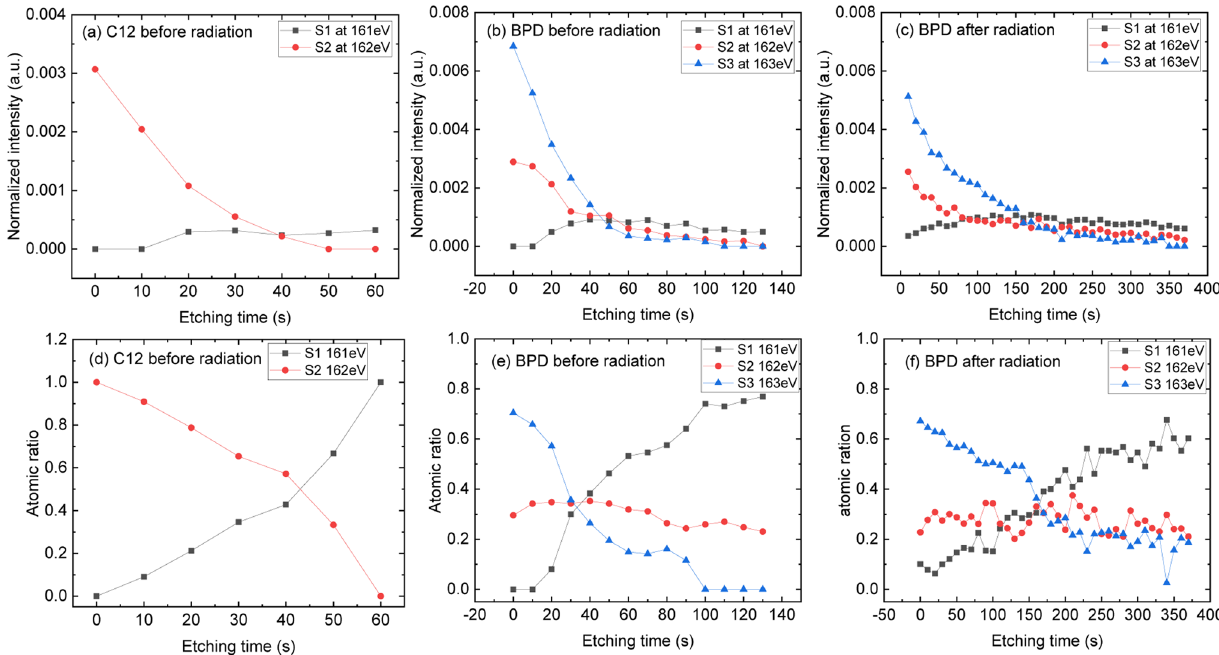
Figure 3. ( a – c ) Intensities (normalized to the Au4f signal) of the components of S2p spectra of pristine C12 SAM ( a ), pristine BPD SAM ( b ) and irradiated BPD SAM ( c ) as a function of etching time. The same results are presented in ( d – f ) normalizing the signal intensities to the total signal intensity to see the percentage contribution of different components. S1, S2 and S3 corresponds to the S2p3/2 at 161.1 eV (component S1), 162.0 eV (component S2) and at 163.5 eV (component S3), respectively.